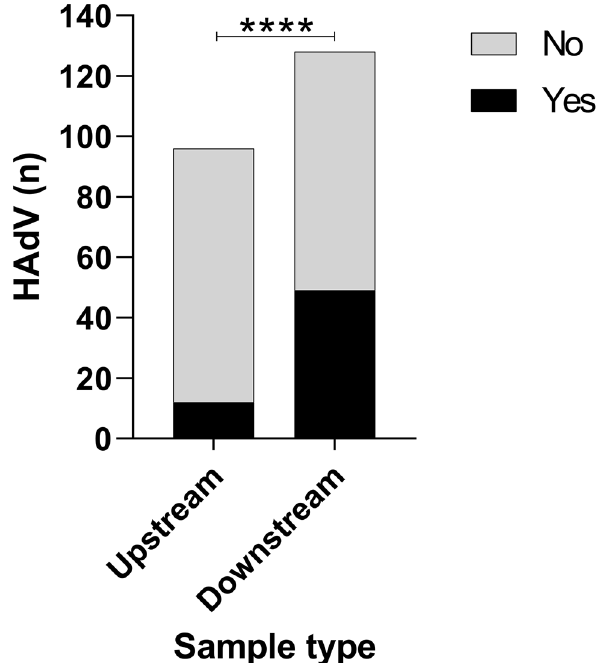
Fig. 1 Frequency of adenovirus by sample type (upstream and downstream); (****) p <